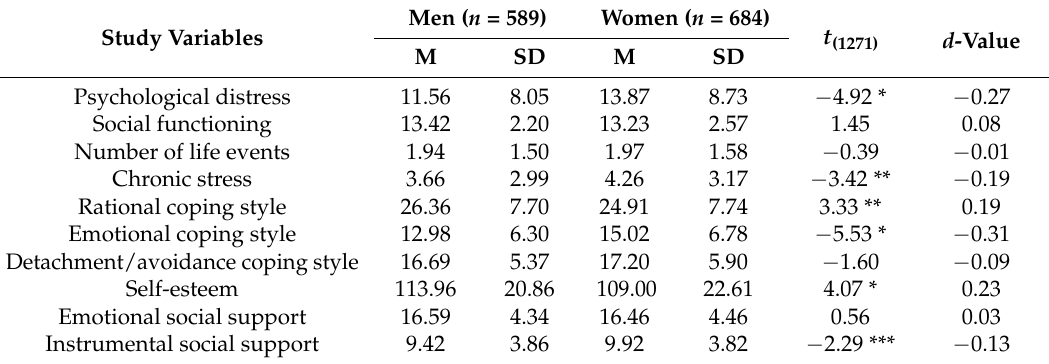
Table 2. Means (M), standard deviations (SD) and comparisons for males and females for the study variables. Men ( n = 589) Women ( n = 684) Study Variables